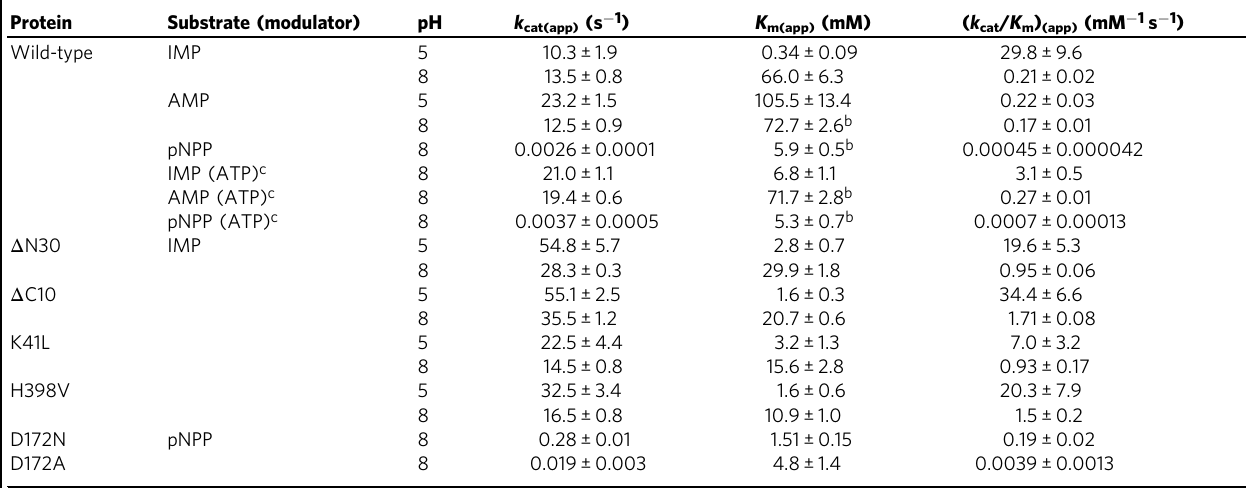
a Values represent mean and SD of the fi tted parameters obtained from three independent measurements. The plots from which the parameters in this table were derived are shown in Supplementary Figs. 6 and 7. The assays at pH 8.0 were carried out in 50mM Tris-HCl, 30mM MgCl 2 , at pH 5.0 in 50mM MES, 30mM MgCl